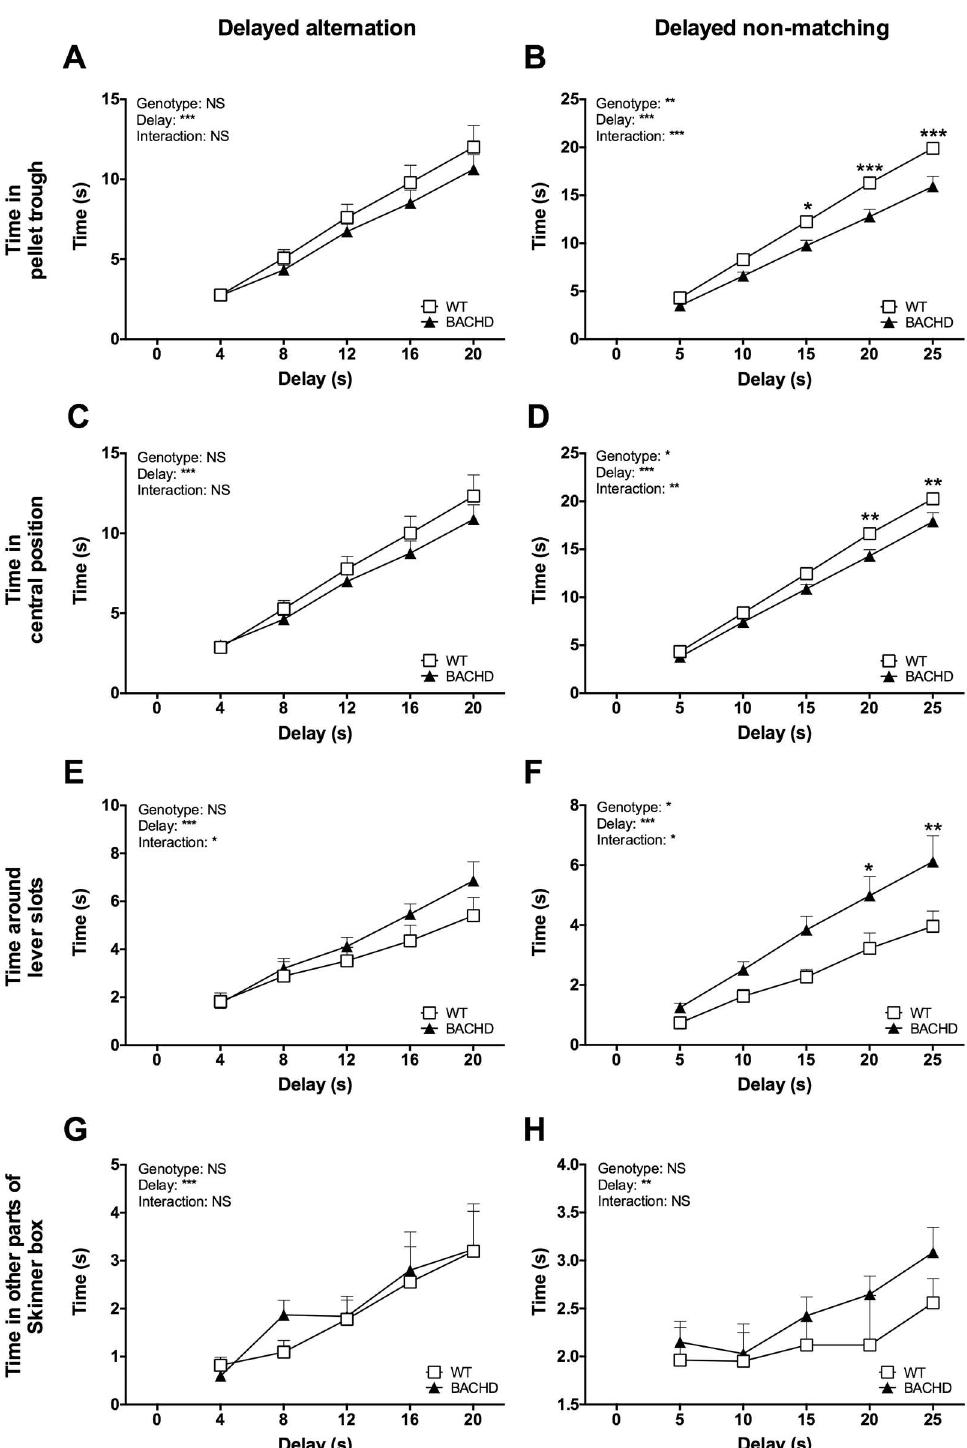
Fig 9. Time spent in different parts of the Skinner boxes during delay steps. The graphs show the time spent in different parts of the Skinner boxes duringdelays in the delayedalternation and delayednon-matching to position tests, as measuredby video scoring. Specific details regardingthe data and scoring method is availablein the Material and Methods section. Graphs indicate group mean plus standarderror. Results from two-way repeatedmeasures ANOVA are showninside the graphs. Results from post-hoc analysisare indicated in case significantgenotypedifferences were found. * ( P < 0.05) ** ( P < 0.01) *** ( P <